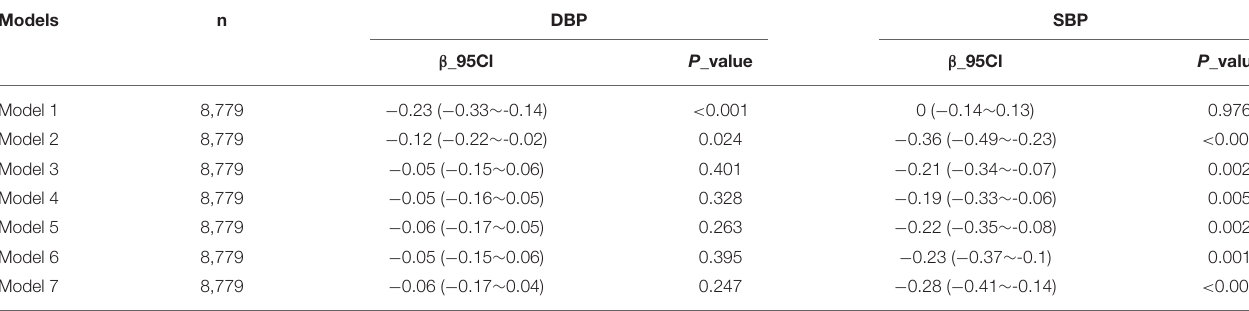
TABLE 2 | Association between serum vitamin D and blood pressure. Models n DBP SBP